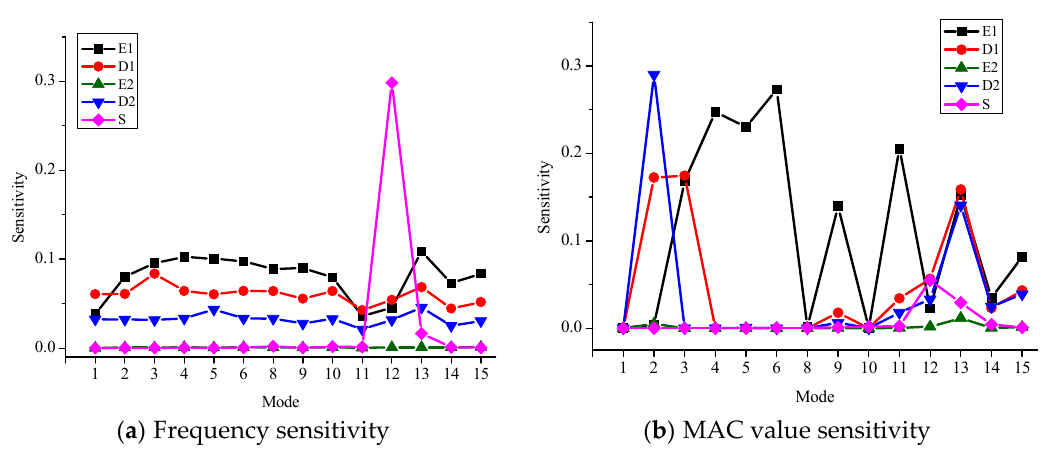
Figure 3. The frequency sensitivity and MAC value sensitivity of the structural parameters.